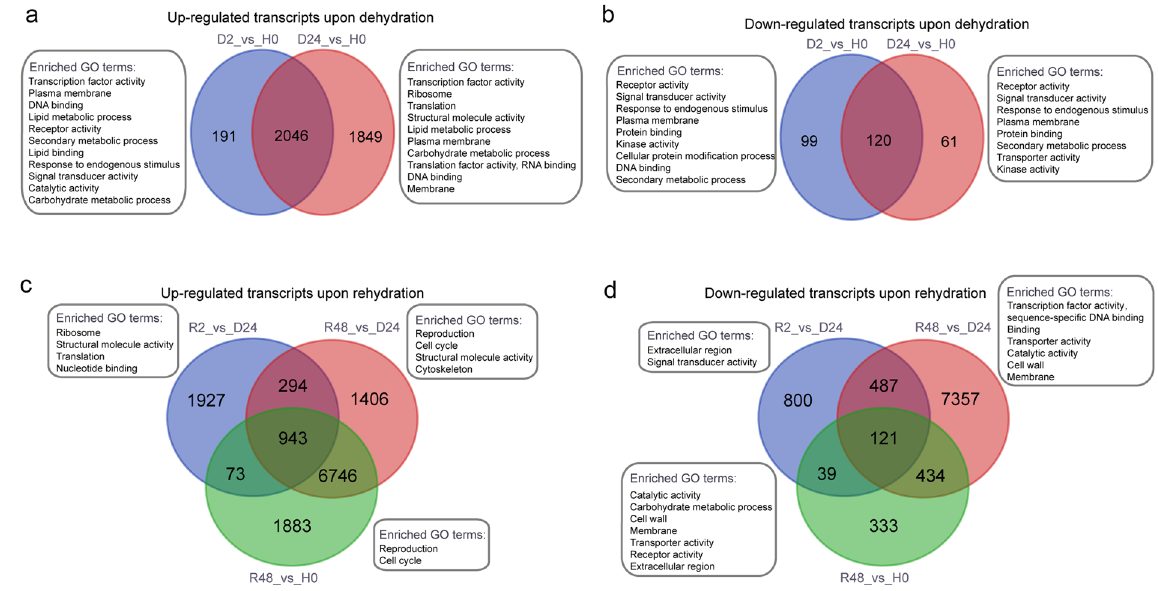
Figure 3. Differentially abundant transcripts and significantly enriched GO terms during dehydration ( a and b ) and rehydration ( c and d ). ( a and b) , Number of transcripts with significantly elevated abundance ( a ) and decreased abundance ( b ) compared to hydrated control during dehydration with enriched GO-slim terms. c and d , Number of abundance elevated ( c ) and abundance decreased ( d ) transcripts compared to desiccated (D24) and hydrated control during rehydration with enriched GO-slim terms. H0: hydrated control, D2: dehydrated 2 h, D24: dehydrated 24 h, R2: rehydrated 2 h, R48: rehydrated 48